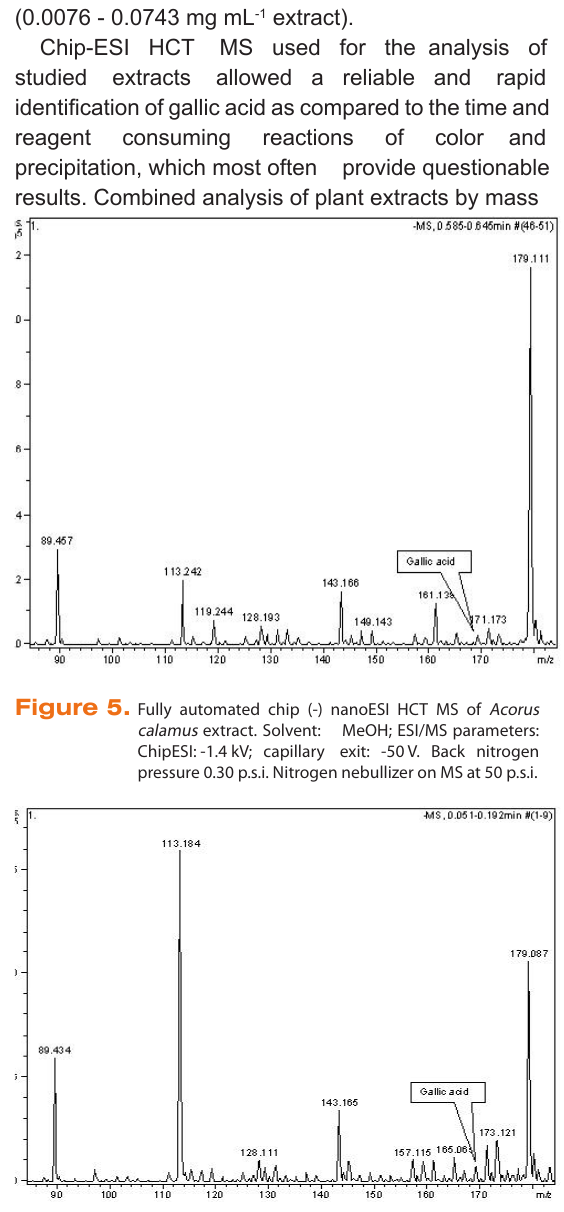
Figure 6. Fully automated chip (-) nanoESI HCT MS of Solidago virga-aurea extract. Solvent: MeOH; ESI/MS parameters: ChipESI: -1.4 kV; capillary exit: -50 V. Back